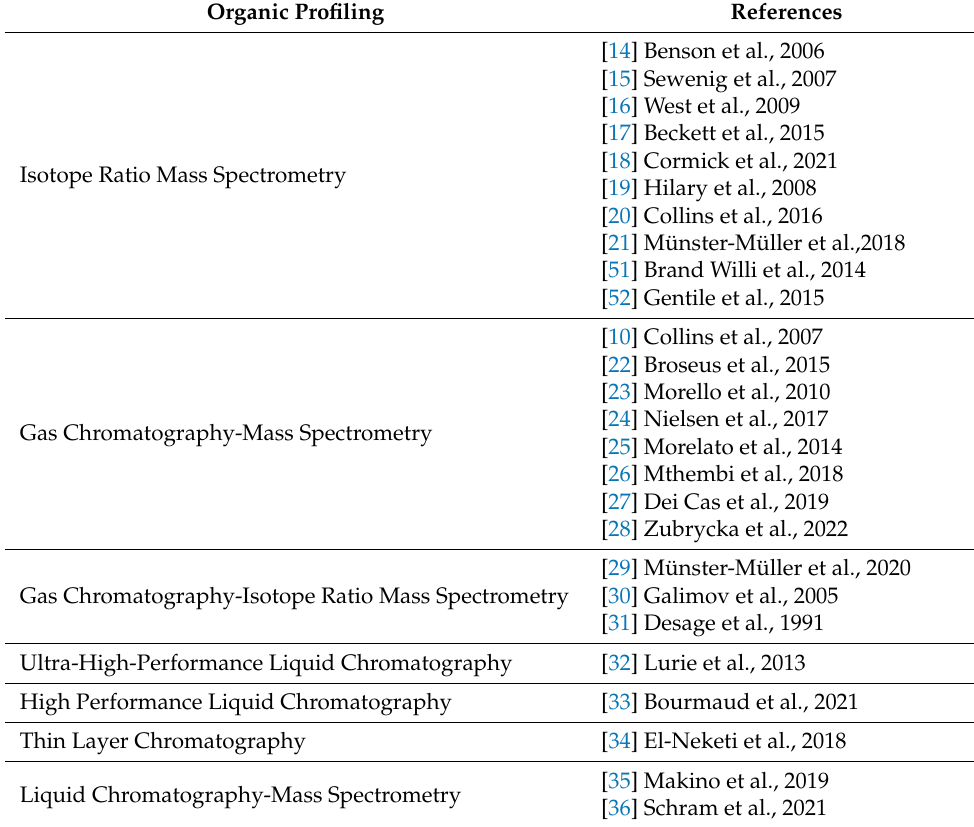
Table 2. Organic profiling of illicit drugs.